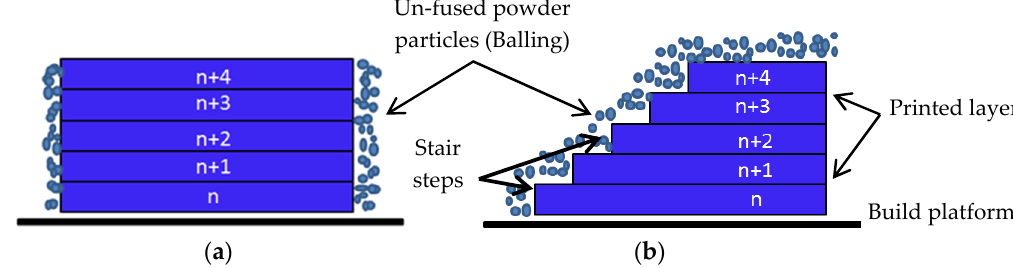
Figure 14. ( a ) Printing in the vertical direction and ( b ) printing curvature geometry.